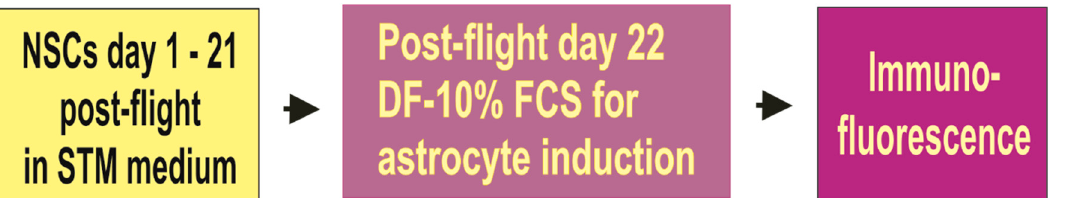
Figure 2. NSCs-derived astrocytes timeline. SPC-flown NSCs were harvested and cultured on poly-d-lysine for 21 days. On post-flight day 22, NSCs were switched to a culture medium containing 10% fetal calf serum (FCS).